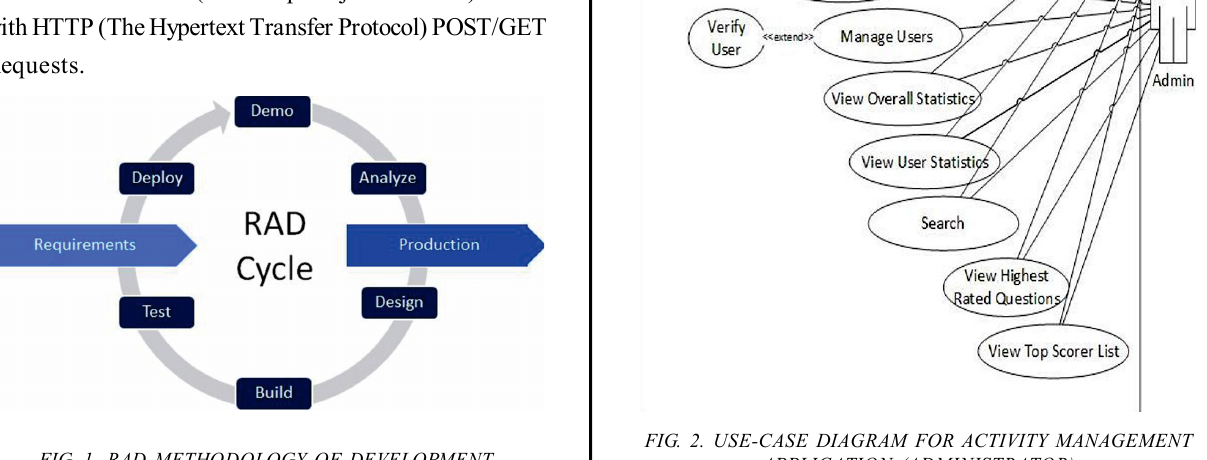
FIG. 1. RAD METHODOLOGY OF DEVELOPMENT